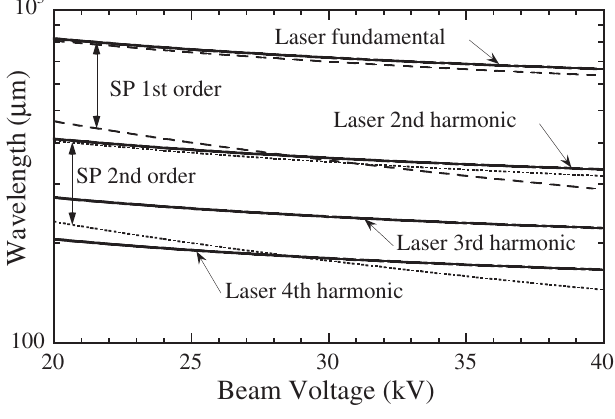
FIG. 2. Wavelengths in the Dartmouth experiments.